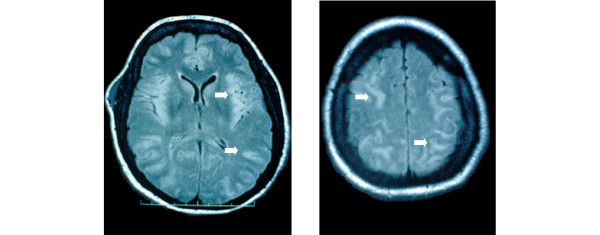
MRI findings in hypoglycemia-related encephalopathy. Cerebral fast fluid-attenuated inversion recovery magnetic resonance imaging (MRI) in a patient suffering from a severe hypoglycaemia-related encephalopathy on day 3 after deliberate insulin self-poisoning. The disseminated hypersignals of the cerebral gray matter (plain arrows) disappeared on day 30, whereas neurological impairments persisted.